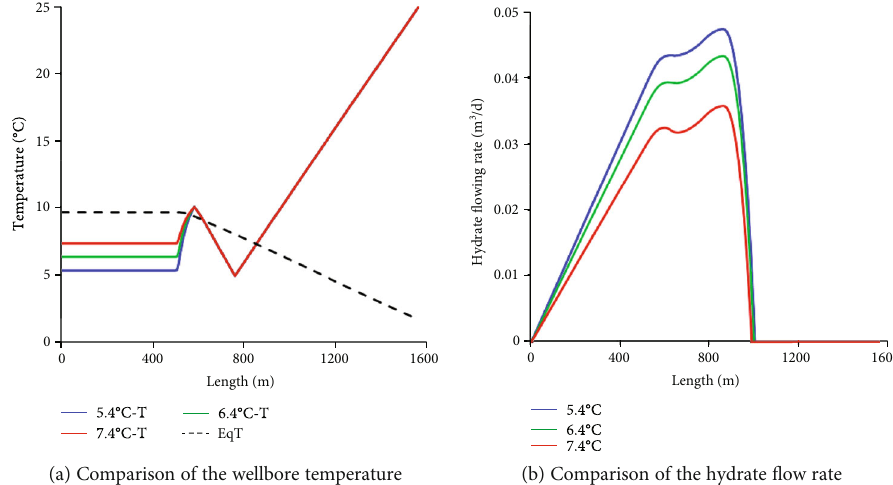
(b) Comparison of the hydrate fl ow rate Figure 9: Comparison of wellbore temperature and hydrate fl ow rate under di ff erent horizontal well environment temperatures.